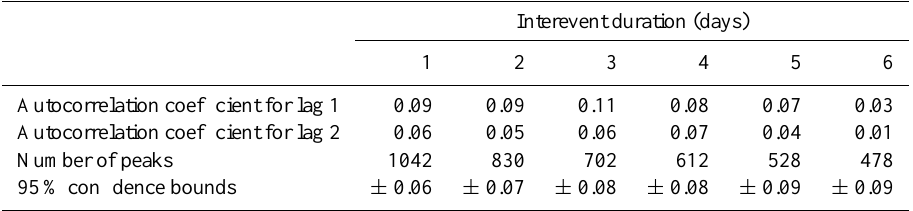
Figure 7 GP distribution fitted to the POT discharge values of the Alt Llobregat sub-basin for the control (1980-2008) and future periods for the A2 (left) and B1 (right) scenarios.